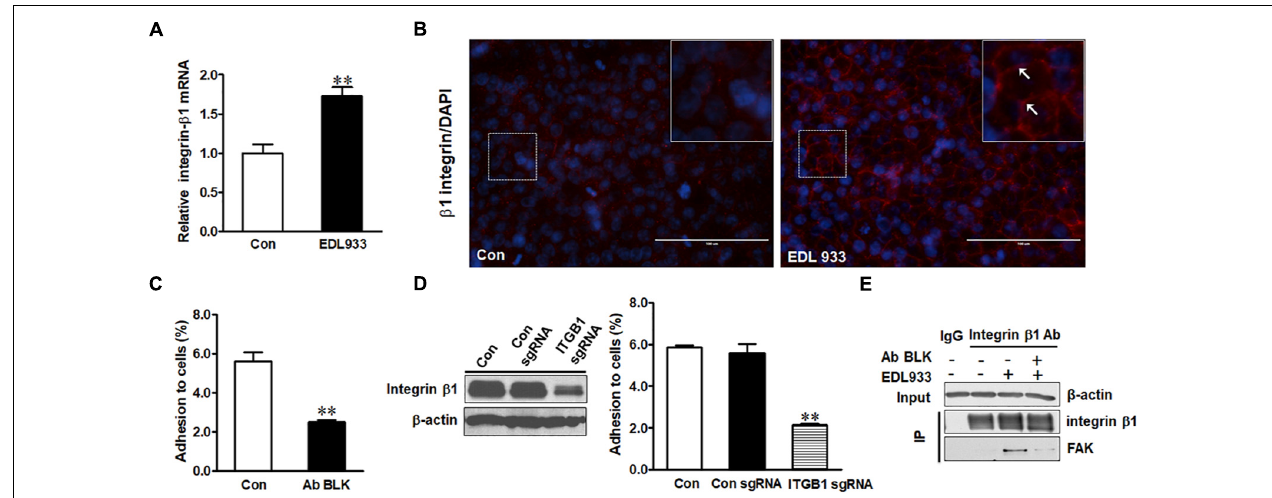
FIGURE 1 | Integrin β 1 mediated E. coli O157:H7 adhesion to Caco-2 cells. (A) mRNA expression of integrin β 1. (B) Immunofluorescence staining for integrin β 1. Blue, DAPI; Red, integrin β 1. Images were taken at 200 × magnification. (C) Bacterial adhesion to Caco-2 cells with or without integrin β 1 antibody blocking (Ab BLK). (D) Integrin β 1 content and bacterial adhesion to Caco-2 cells transfected with scramble control (Con sgRNA) or integrin β 1 knockout (ITGB1 sgRNA) plasmid. (E) Co-immunoprecipitation analysis of integrin β 1 and FAK interaction. Input, the whole cell lysate detected with β -actin; IP, lysates post integrin β 1 immunoprecipitation were detected with integrin β 1 or FAK antibody. Caco-2 cells were co-cultured with EDL933 strain for 4 h before respective analyses. Means ± SEM; n = 4. ∗∗ P ≤ 0.01.